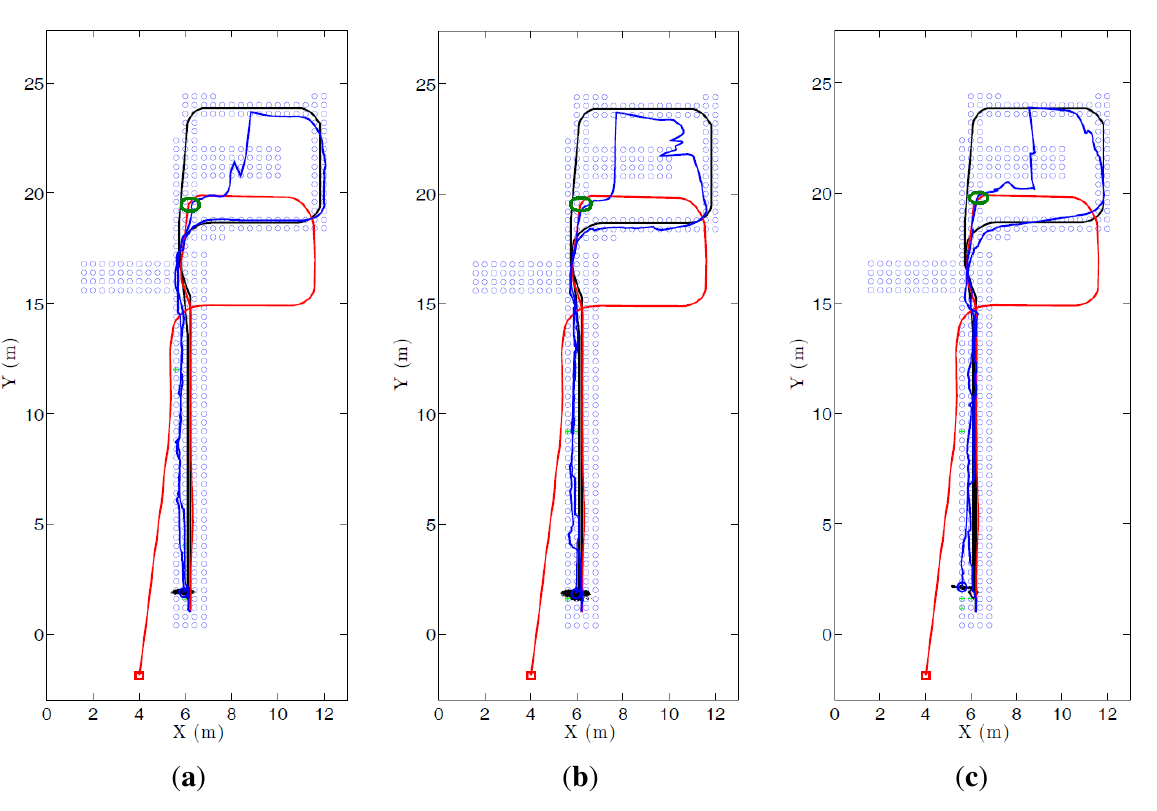
( a ) Fourier Signature; ( b ) HOG and ( c ) gist . The blue dots are the positions of the map images, the black curve is the ground truth of the route followed by the robot, the red curve is the trajectory estimated using only the odometry data and the blue curve is the trajectory estimated making use of the probabilistic